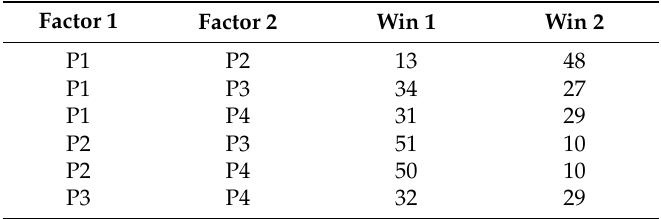
Table 6. Input file of Perspectives (P) preferences in a win-to-loss context.